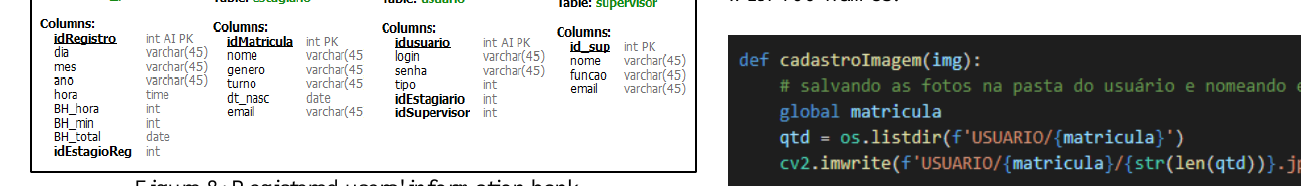
Figure 11: Function for registering faces in the image bank.